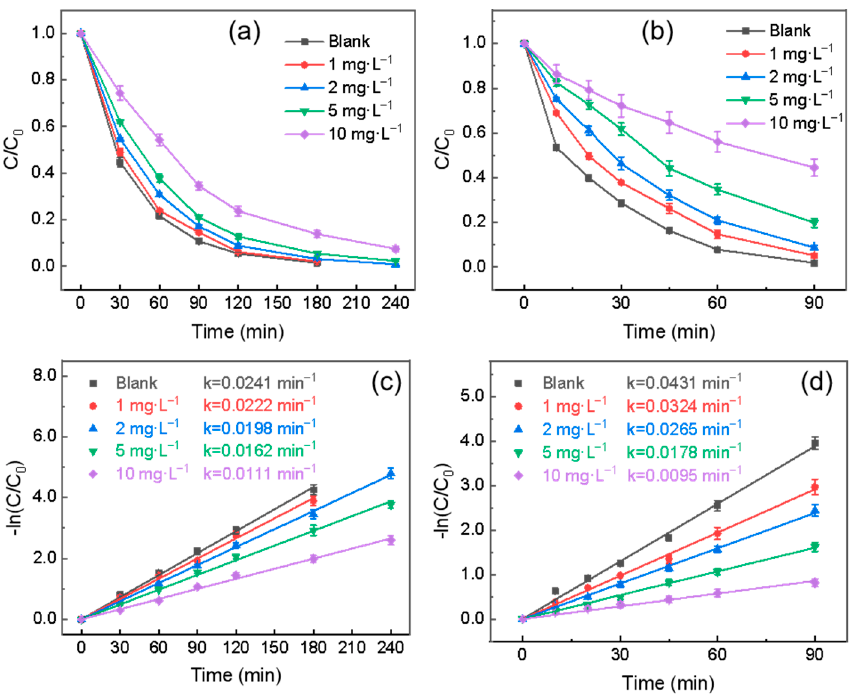
Figure 5. The impact of different amounts of humic acid on the photodegradation of ( a ) SMX and ( c ) ENR, and kinetic curves of ( b ) SMX and ( d ) ENR.